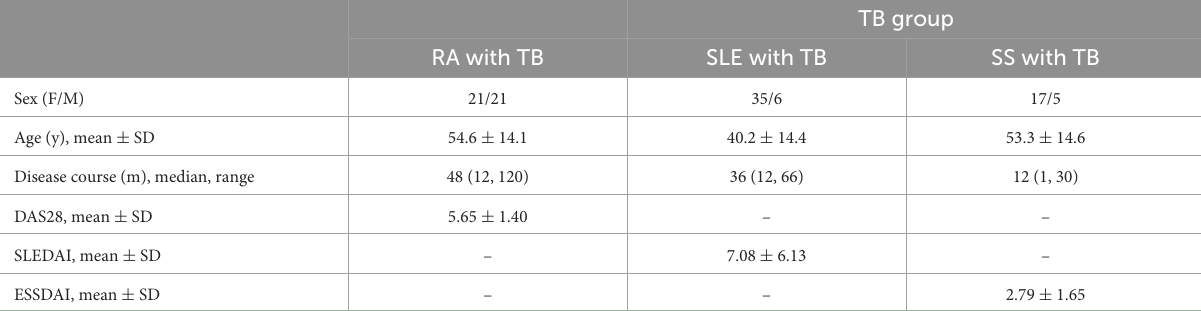
TABLE 1 General information of patients in the TB